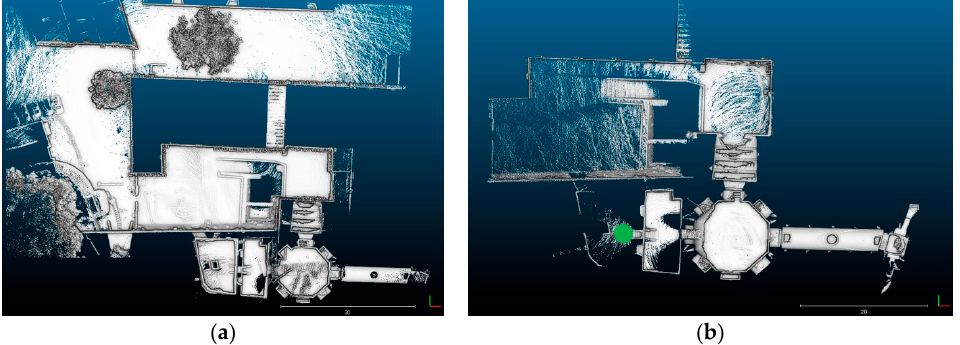
Figure 6. Kaarta Stencil datasets: ( a ) path 1; ( b ) path 2.